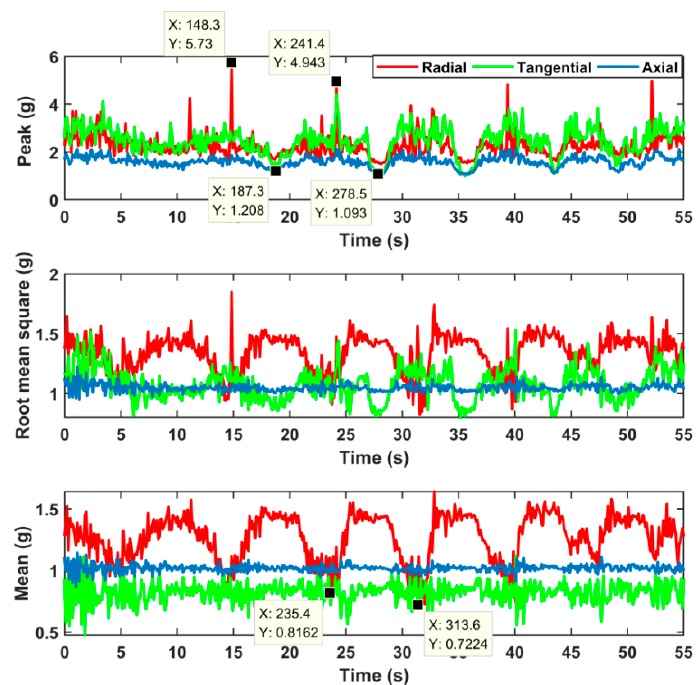
Figure 7. The peak value, root mean square value, and mean value curve of the time domain signal intercepted from the 4700~4720-m section according to a time window with a length of 100 signal points.